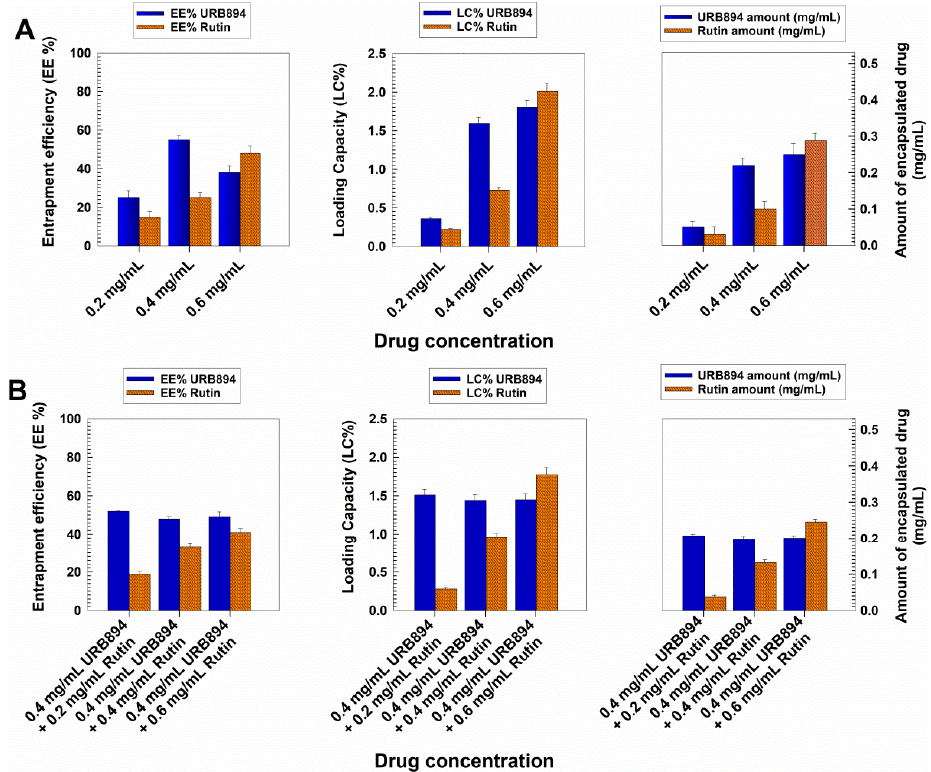
Figure 4. Entrapment efficiency and loading capacity of URB894 and rutin within PLGA nanoparticles encapsulated as ( A ) single agents or ( B ) in association in multidrug formulations as a function of the drug concentration used. Results are reported as the mean of three different experiments ± standard deviation.